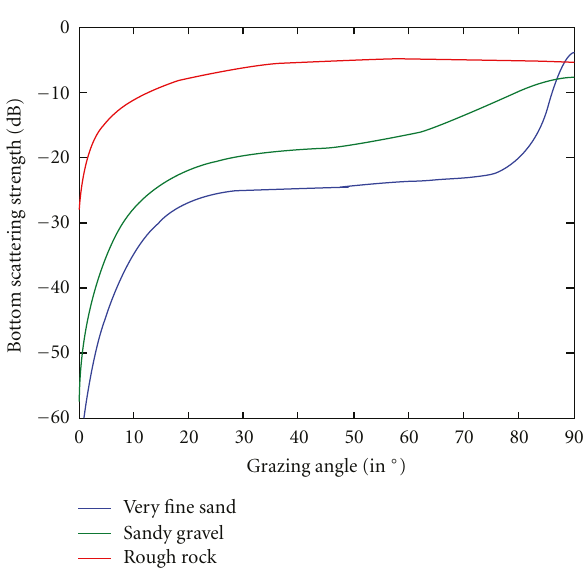
Figure 6: Bottom scattering strengths against grazing angle for three seabed types.